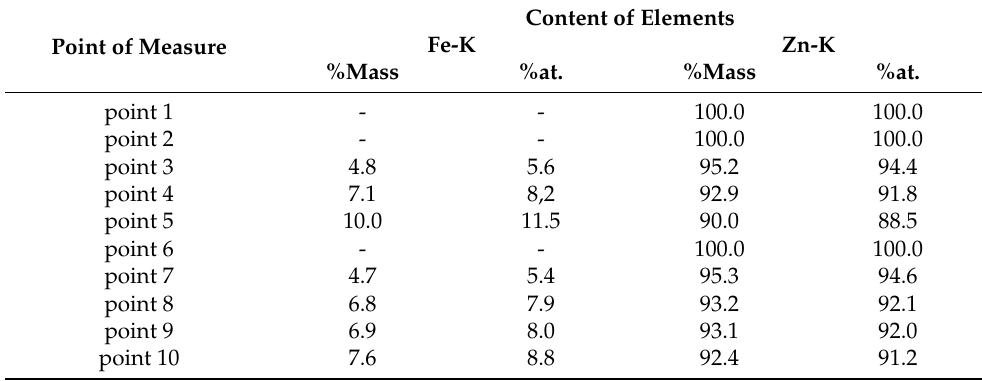
Table 3. Chemical composition in selected micro-areas of the coating obtained on the wire in variants K5 and H5.